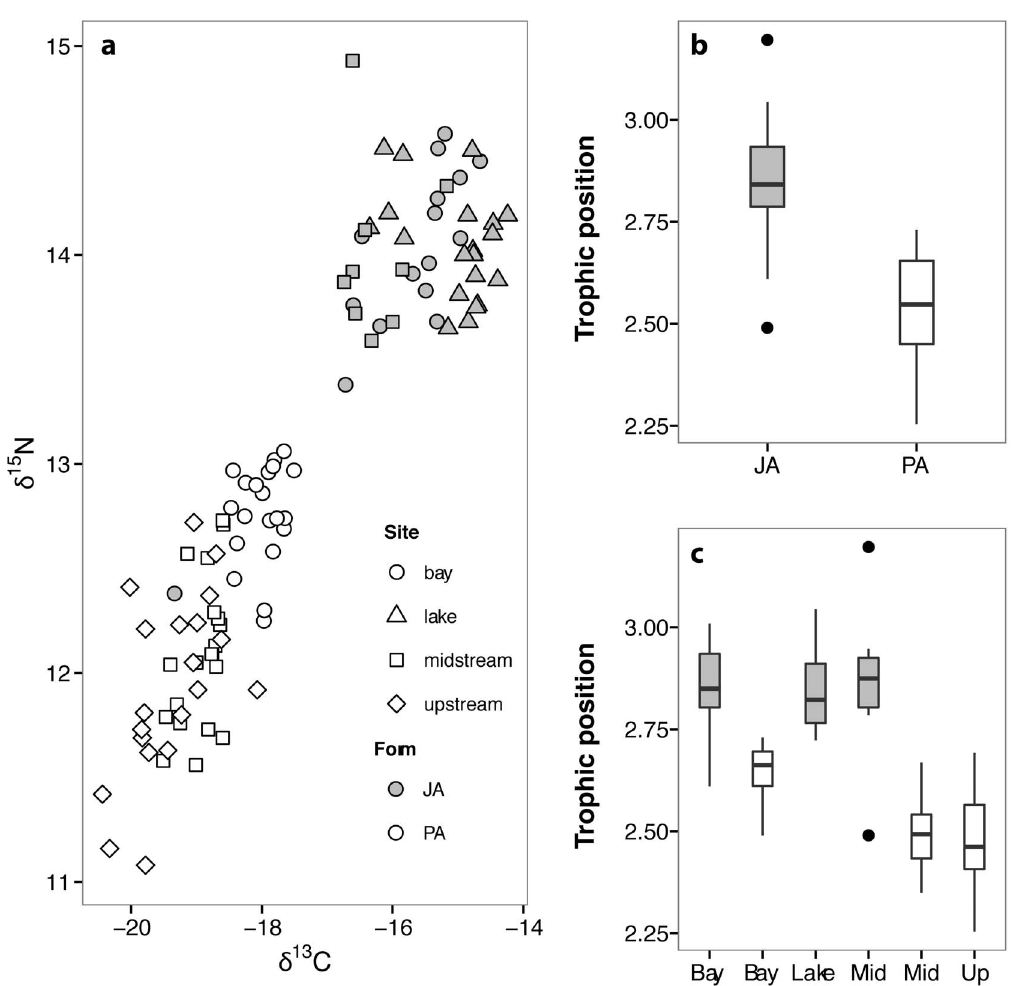
Figure 2. Stable isotope values for stickleback from the Bekanbeushi River system: a) d 13 C and d 15 N biplot; boxplots showing difference in trophic position between b) JA and PA forms and c) among forms captured at different sites within the catchment. NB: we are not able to explain why a single JA individual is present amongst the PA. Assignment was performed using species-specific microsatellites but we cannot rule out the possibility this sample was mislabelled.